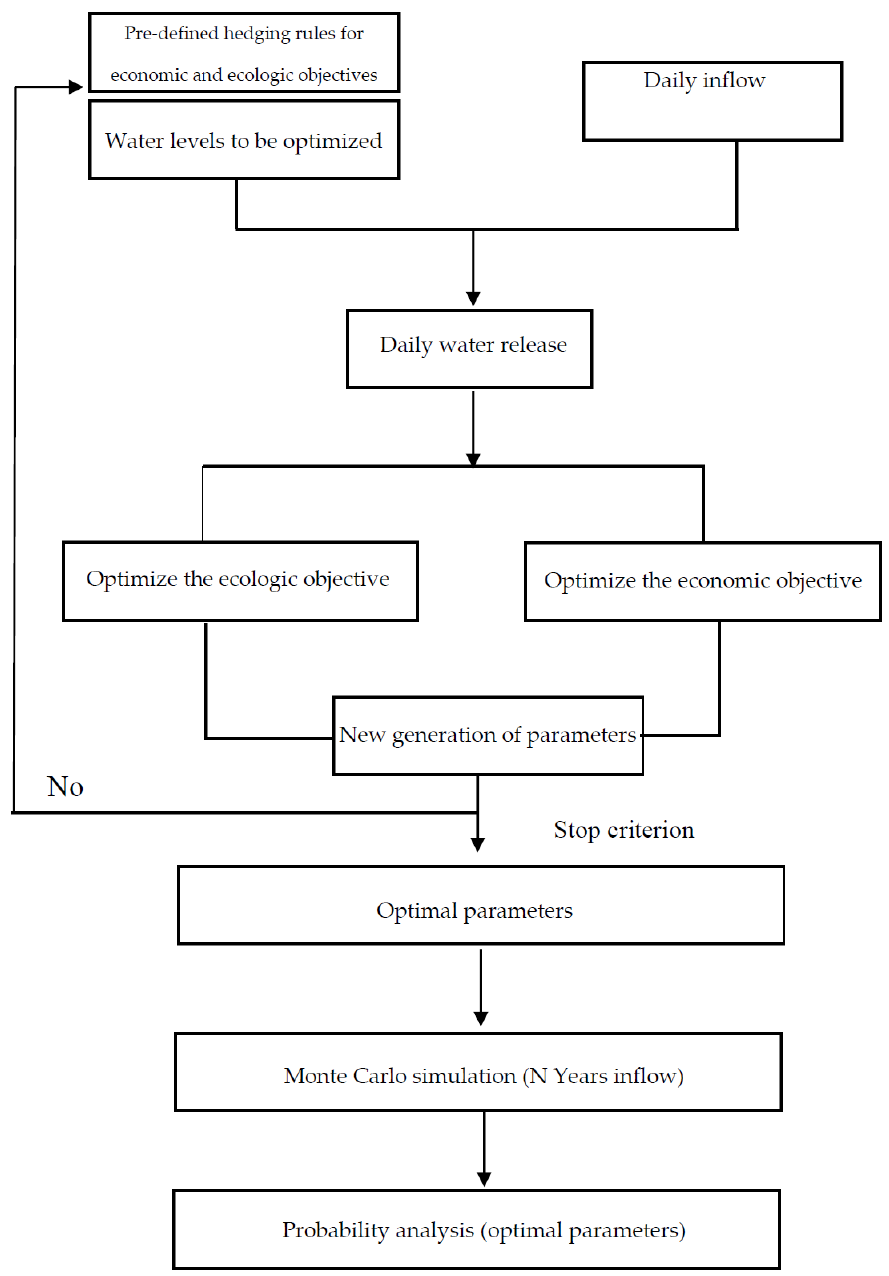
Figure 1. Process diagram for optimizing the operating rules.